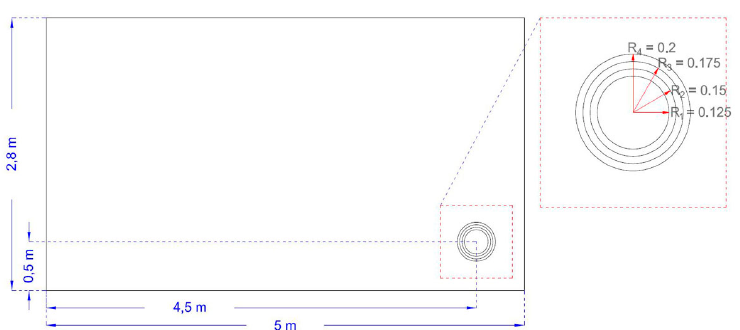
Figure 16. Image that shows the dimensions of the complete wall and a graphic representation of the hole synthesized in a circle of known radius.